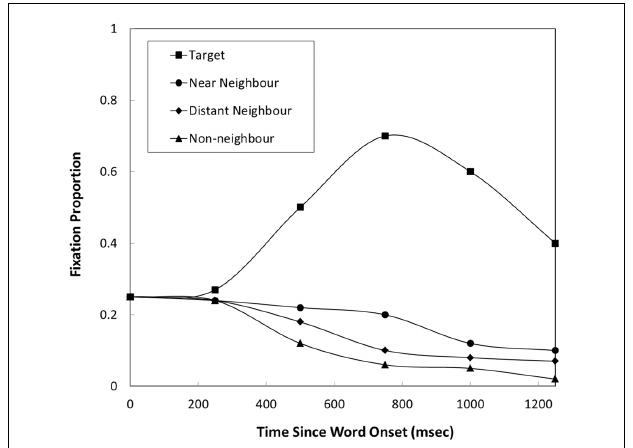
FIGURE 1 | Figure adapted from Mirman and Magnuson (2009). Figure displays approximate fixation proportions for targets, near semantic neighbors, distant semantic neighbors and unrelated items displayed by participants in Mirman and Magnuson